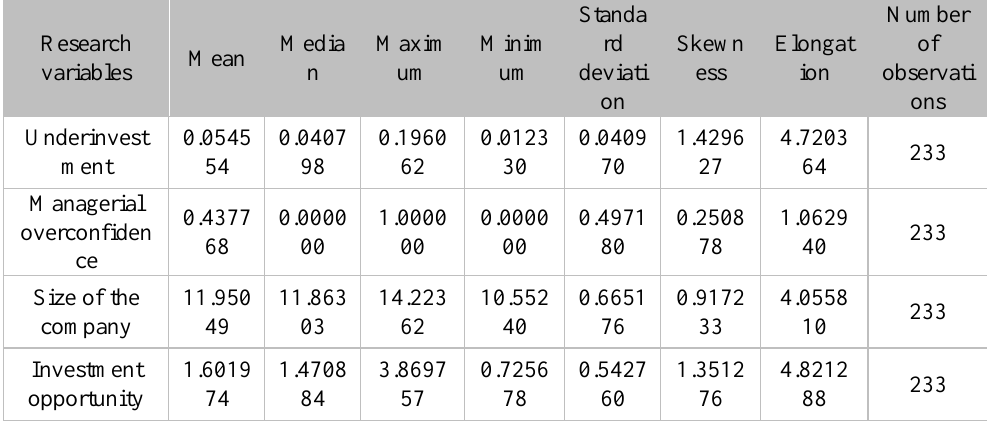
Table 4. Descriptive statistics -